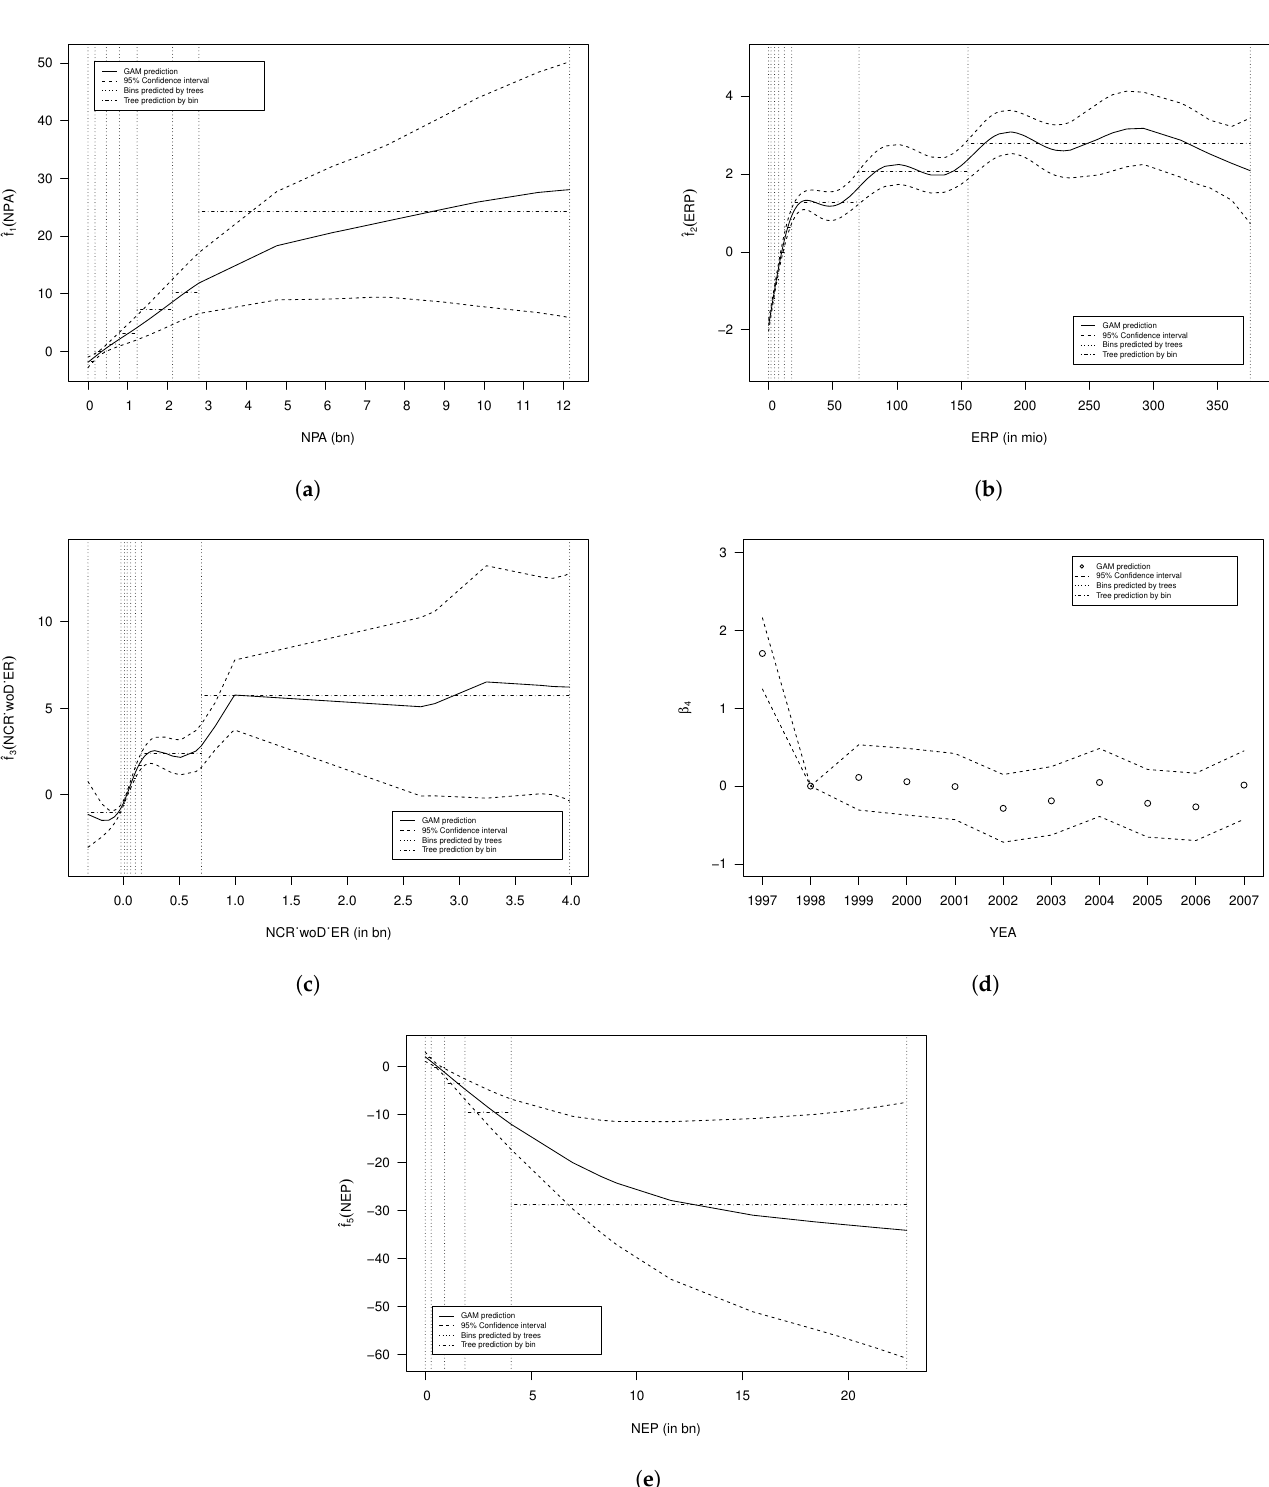
Figure 2. Effects on the equalization reserves for non-life undertakings. ( a ) Effect of the net claims pay- ments. ( b ) Effect of the equalization reserves of the previous year. ( c ) Effect of the net change in claim reserves without change in ER . ( d ) Effect of the calendar year. ( e ) Effect of the net earned